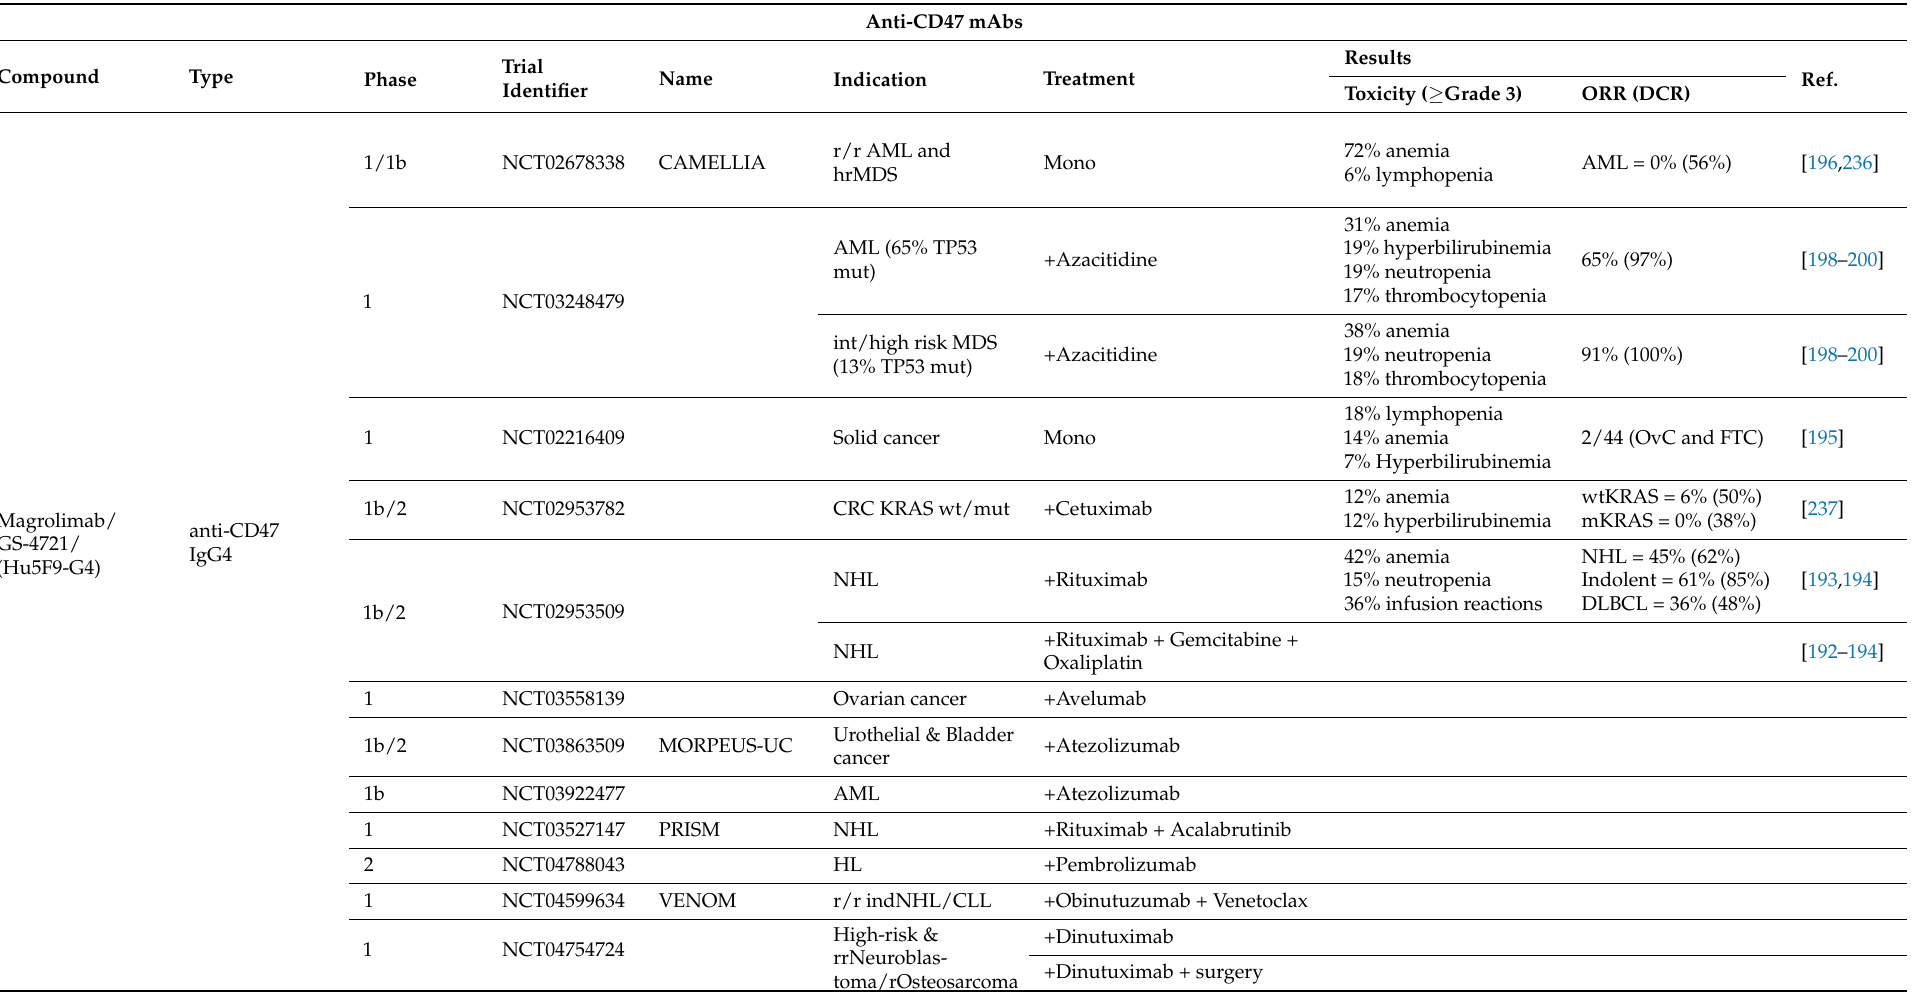
Table 2. CD47-targeting antibodies investigated in clinical trials. Currently, 25 anti-CD47 mAbs are investigated in 73 clinical trials, as mono- or combination therapy for various indications. Table updated until 7 April